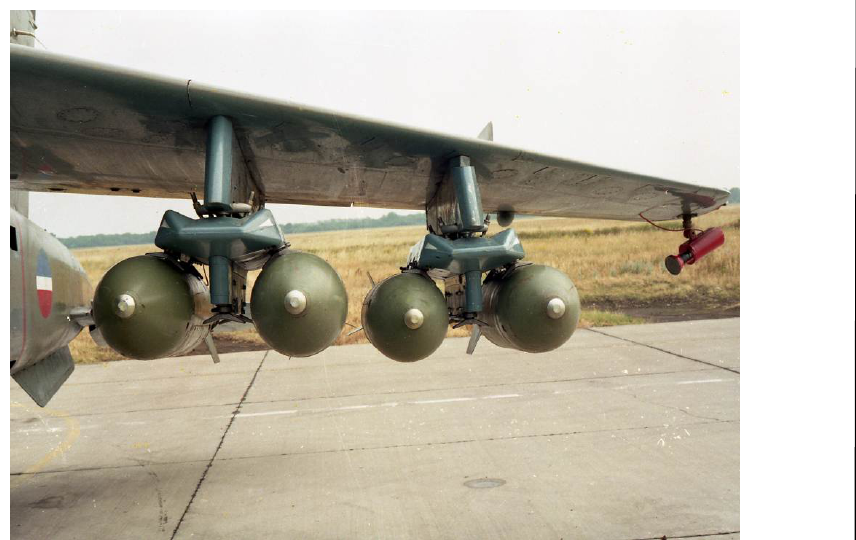
Figure 6 – Ultra high speed cameras to record separation of bombs from bomb-carriers (Arhiv Vazduhoplovnog opitnog centra, 2016)